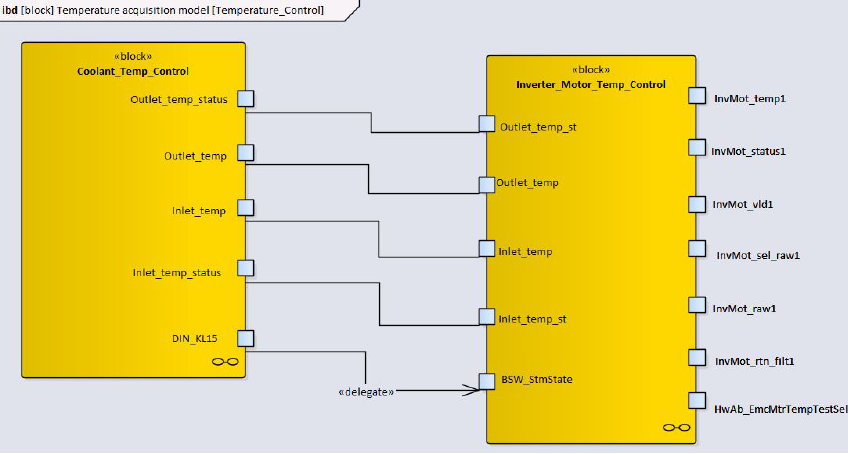
Figure 4. Architecture design using SysML in